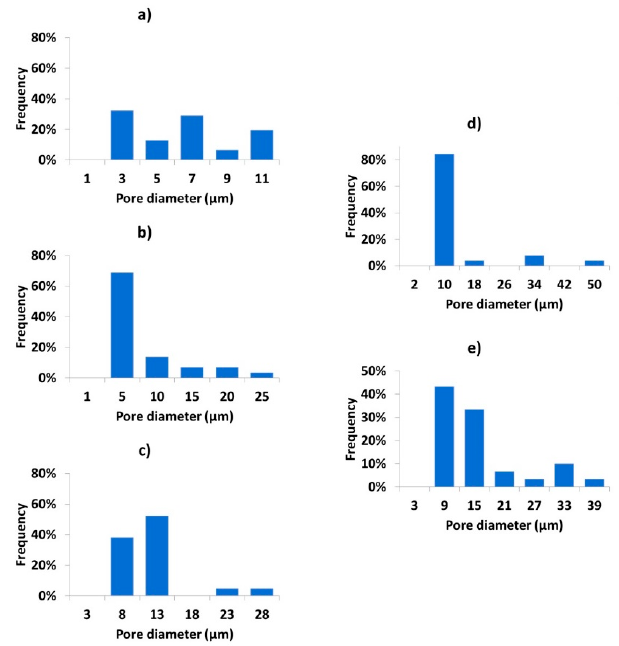
Figure 3. The pore size distribution histograms of membranes: ( a ) L0; ( b ) L2; ( c ) L5; ( d ) L10; ( e ) L20.